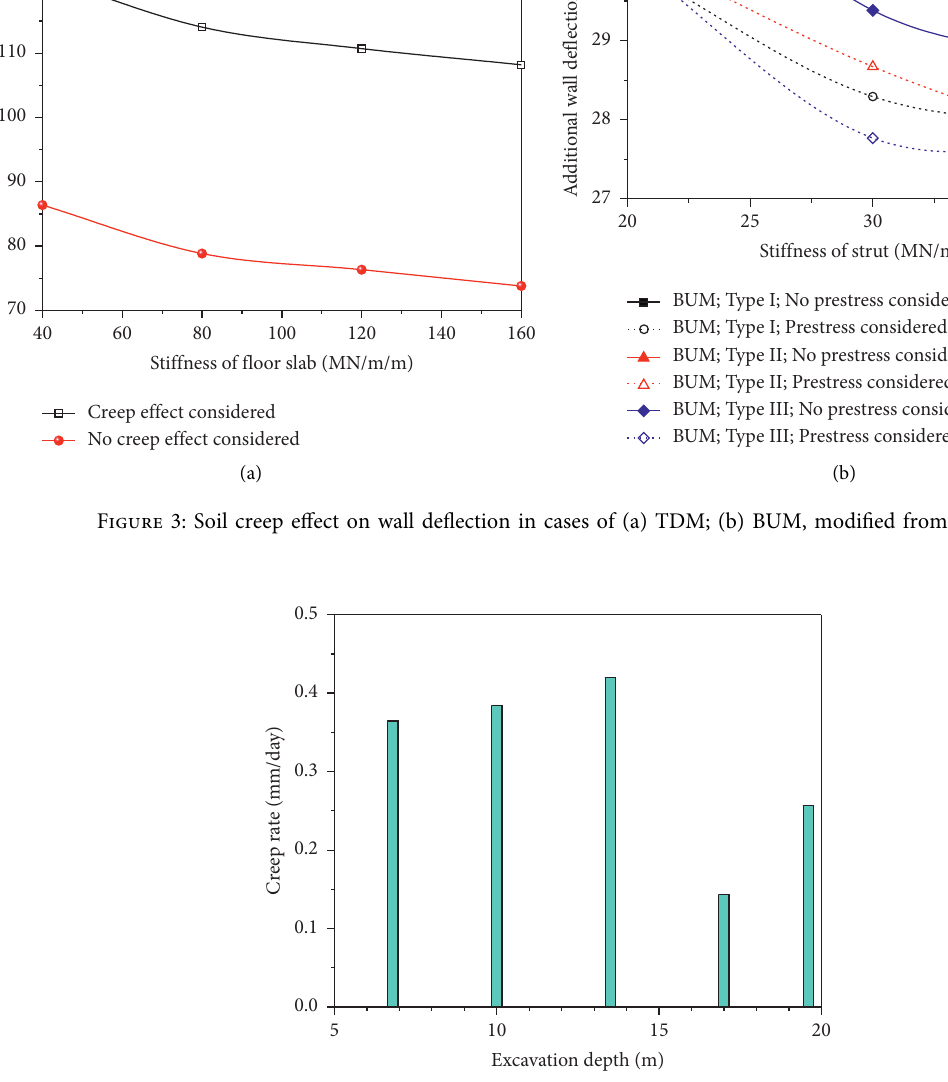
Figure 4: A comparison of creep rates at different excavation depths, modified from